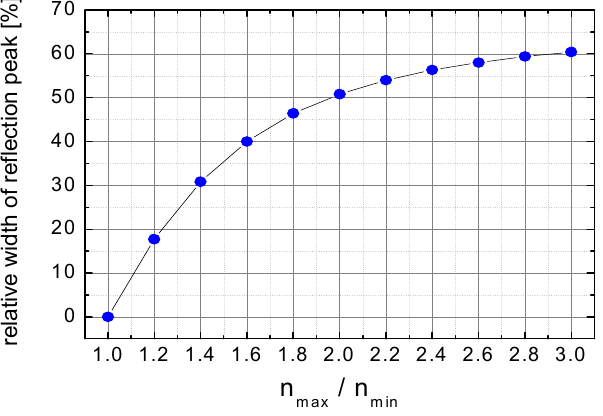
Figure 1. Relative width of the reflection peak of a Rugate filter as a function of the relation of maximum and minimum refractive index of the filter. A relative width of 25% means that, if the design wavelength of the Rugate filter is λ the peak will be ca. 200 nm and the peak will cover a range between λ and λ = 900 nm. +